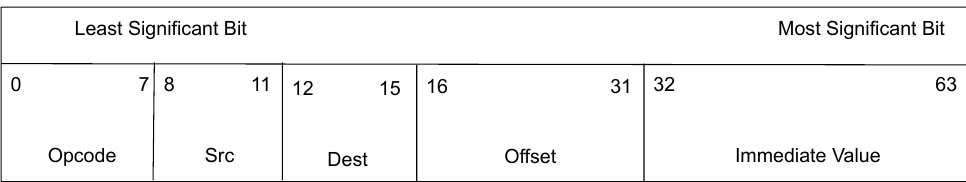
Figure 4. eBPF instruction